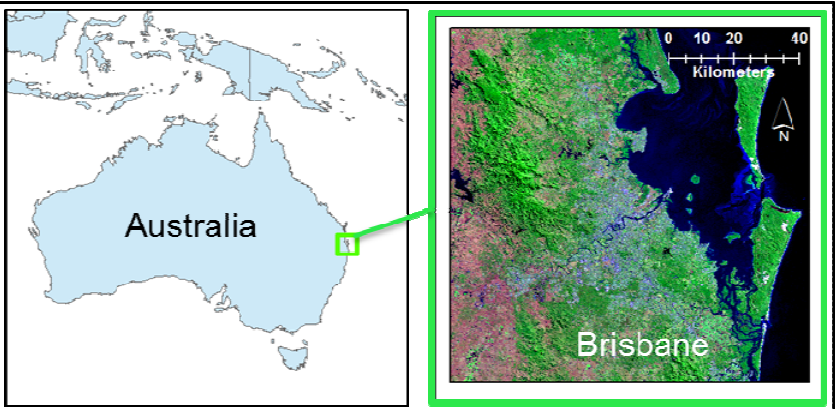
Figure 1. The study area extent centred on the sub-tropical city of Brisbane, Australia. Satellite image provided by Geosciences